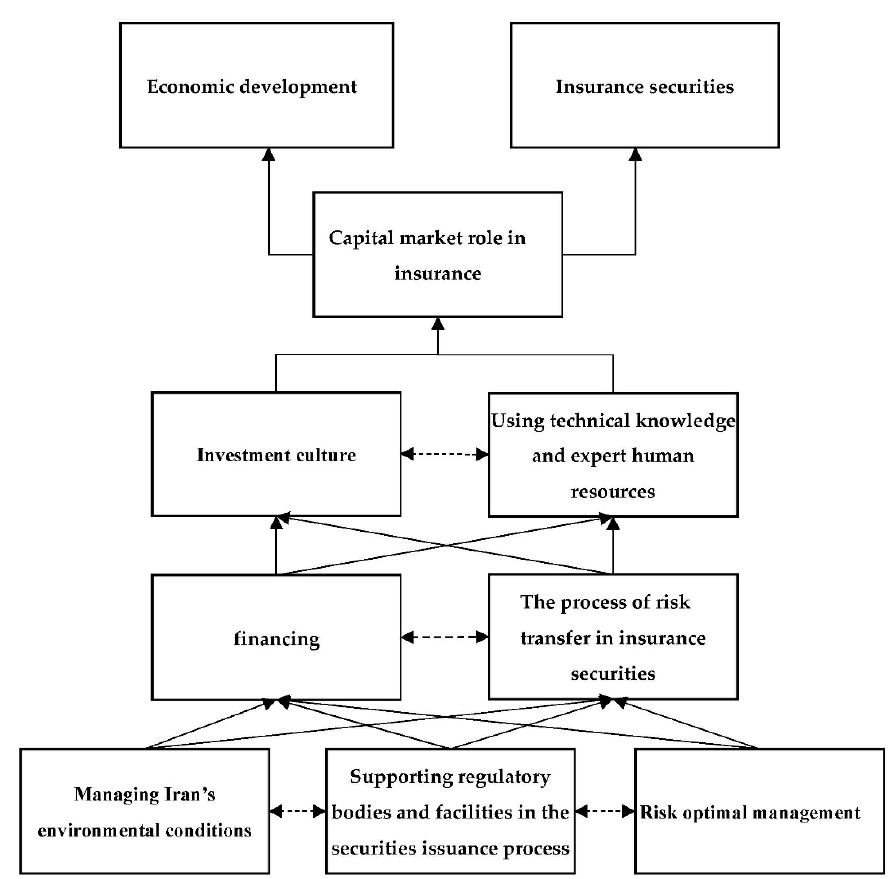
Figure 1. The pattern of insurance securities in Iranian environmental conditions. Source: research findings.